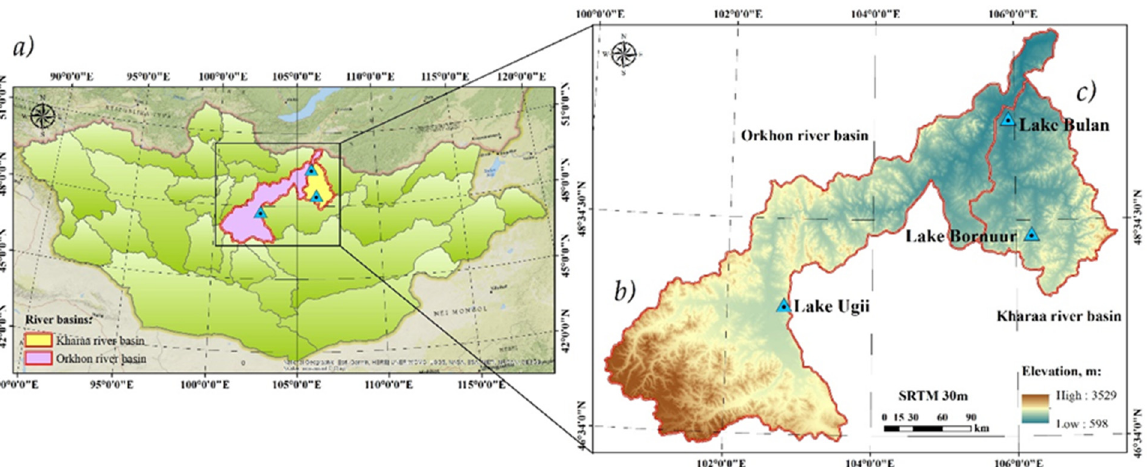
Figure 2. Research area: ( a ) River basins in Mongolia; ( b ) Orkhon River basin; and ( c ) Kharaa River basin. The map cited from Environmental Information Center (EIC) meta data [40], WGS84: 49N, Map cited from Sources: National Geographic, Esri, Garmin, HERE, UNEP-WCMC, USGS,